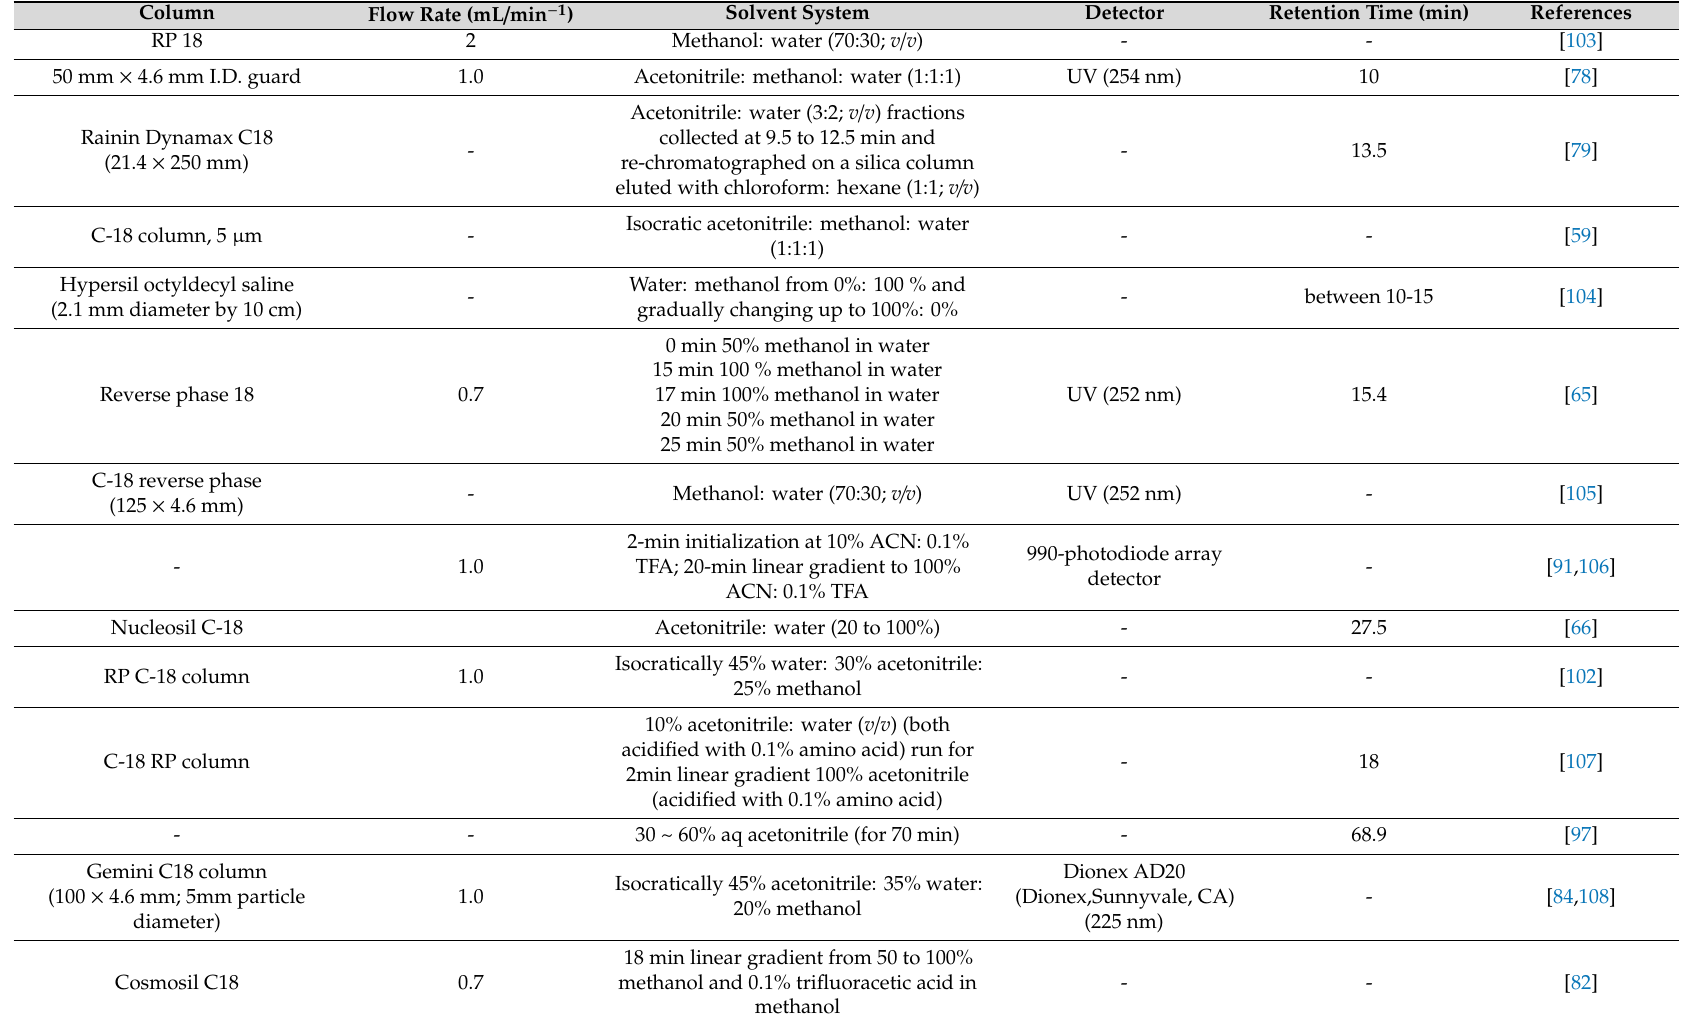
Table 5. Several HPLC methods adopted to separate and quantify pyrrolnitrin from microbes using di ff erent solvent